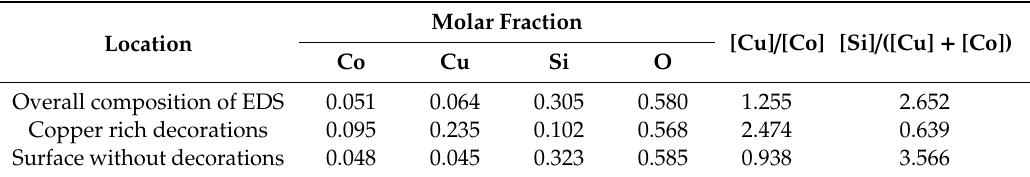
Table 12. Molar atomic composition of the Co / Cu / Si = 1 / 1 / 8 catalyst at various regions when the catalyst was synthesized at microwave power of 1800